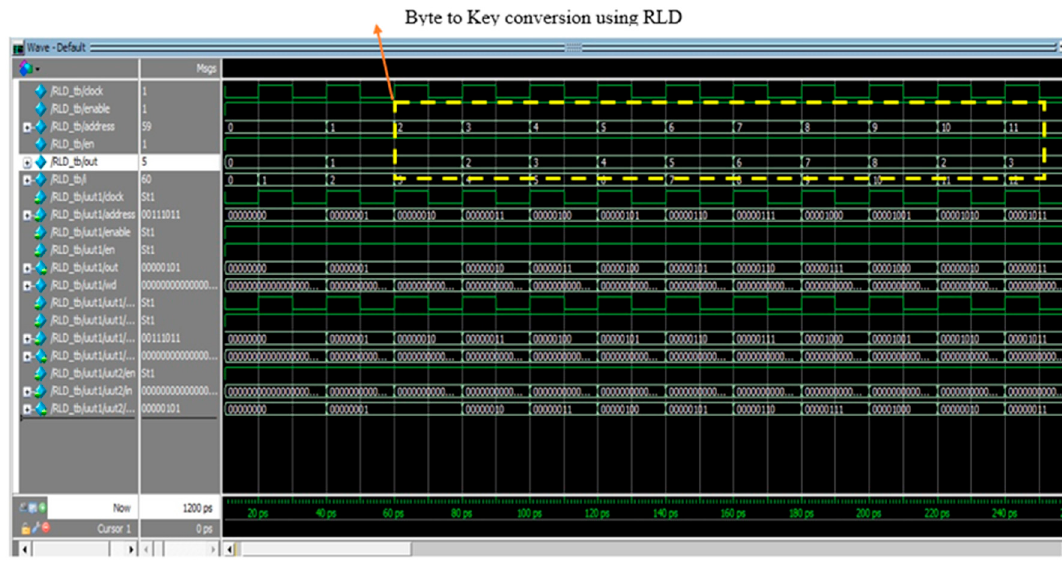
Figure 6. Logic verification of reverse lookup dictionary (RLD) module.